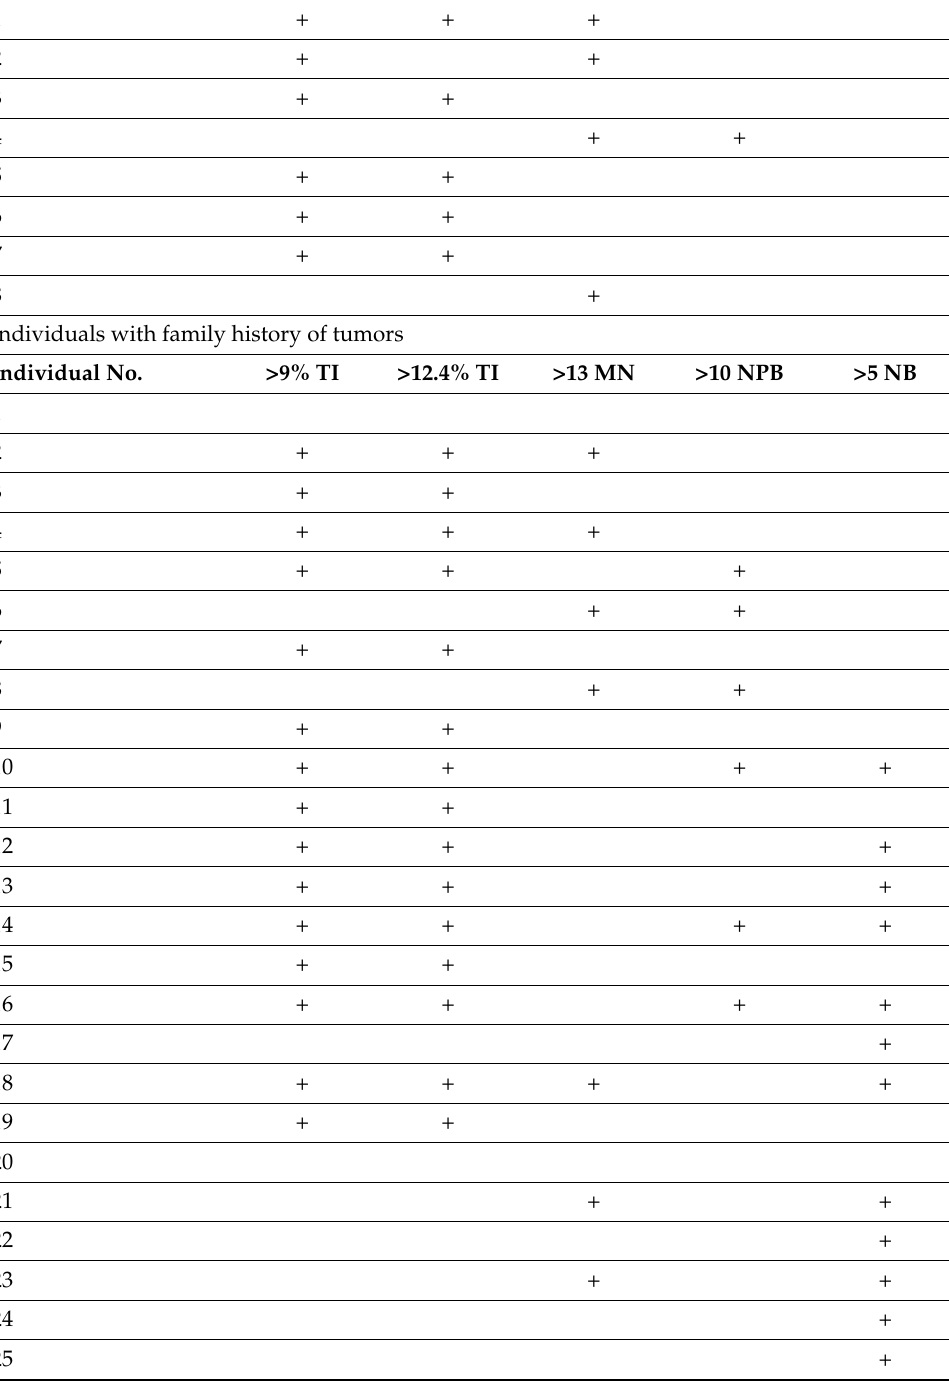
Table 7. Demonstration of the individual levels of DNA damage for both comet and CBMN assay for individuals with previous tumors and the ones with family history of tumors. Individuals with previous tumors Individual No. >9% TI >12.4% TI >13 MN >10 NPB >5 NB